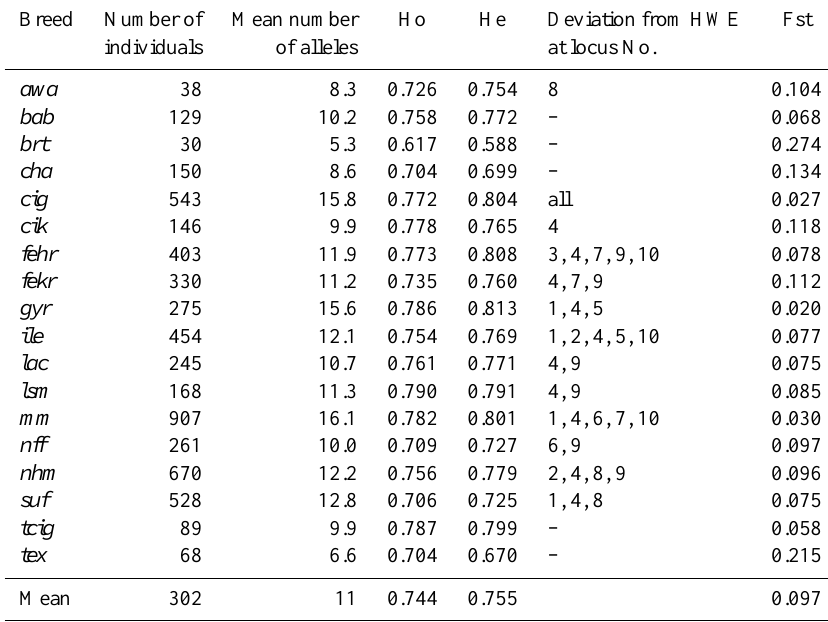
Table 4. Pairwise Fst values for all 18 breeds. All pairwise Fst’s were significant at P <0.005 after 110 permutations. Breed awa bab brt